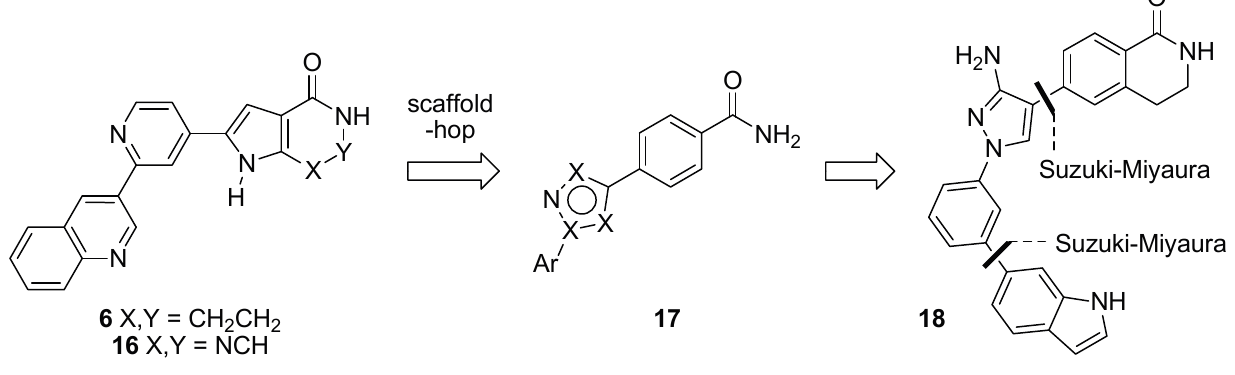
Figure 7. Scaffold-hopping strategy of Velcicky et al. [53], showing the use of Suzuki-Miyaura aryl-aryl coupling for scaffold